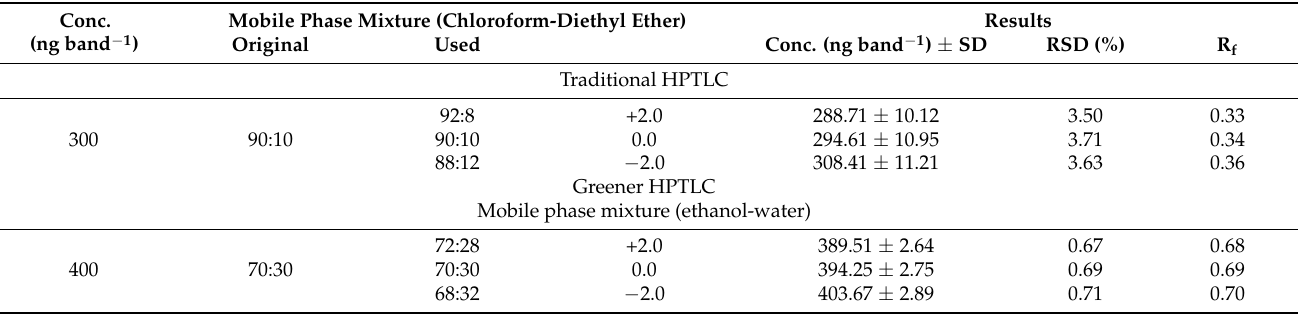
Table 5. Measurement of VD3 robustness for traditional and greener HPTLC methods (mean ± SD; n =